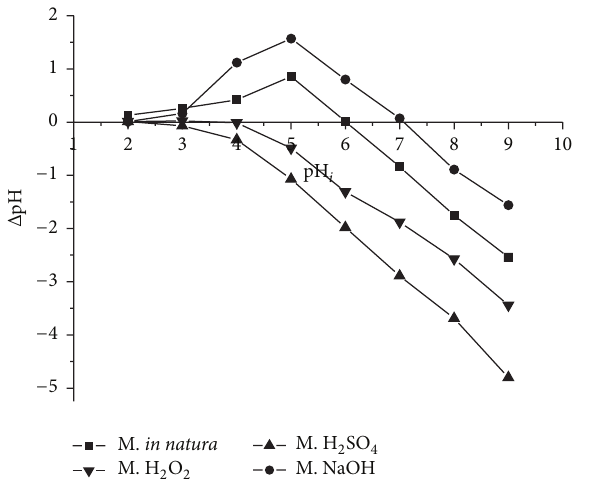
Figure 1: pH PZC for the adsorbents M. in natura , M. H 2 O 2 , M. H 2 SO 4 , and M.